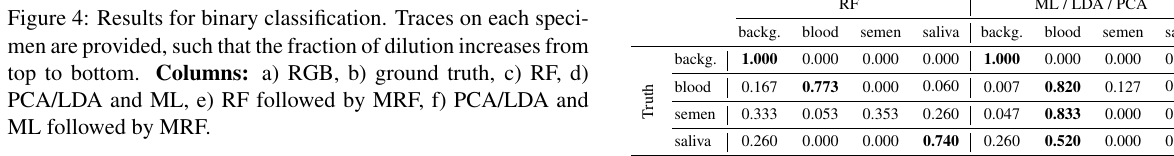
Figure 4: Results for binary classification. Traces on each speci- men are provided, such that the fraction of dilution increases from top to bottom. Columns: a) RGB, b) ground truth, c) RF, d) PCA/LDA and ML, e) RF followed by MRF, f) PCA/LDA and ML followed by MRF.